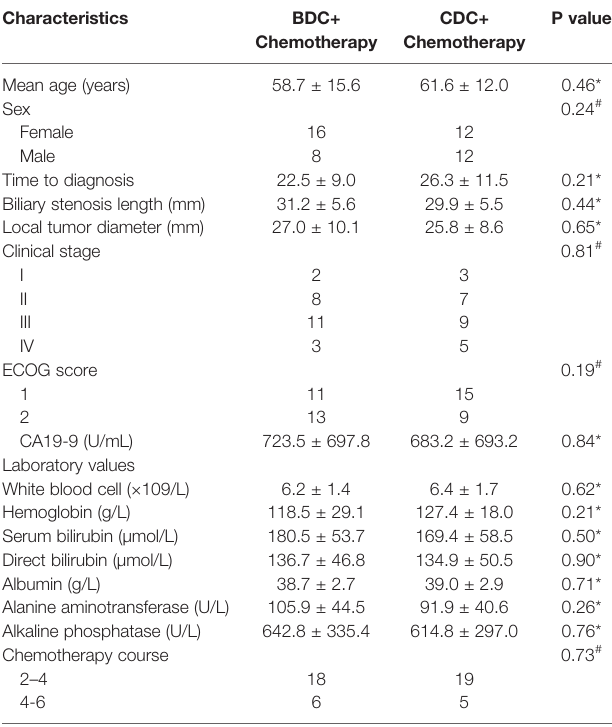
TABLE 1 | Patient characteristics.